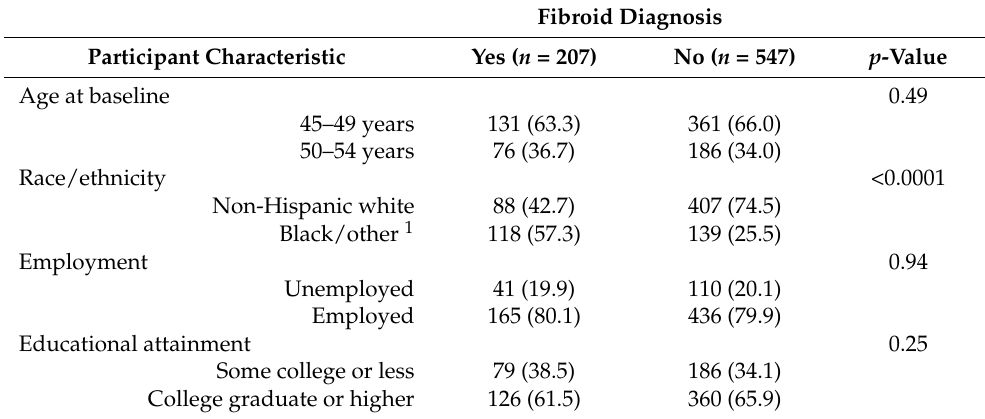
Table 1. Demographic and lifestyle characteristics of women with and without uterine